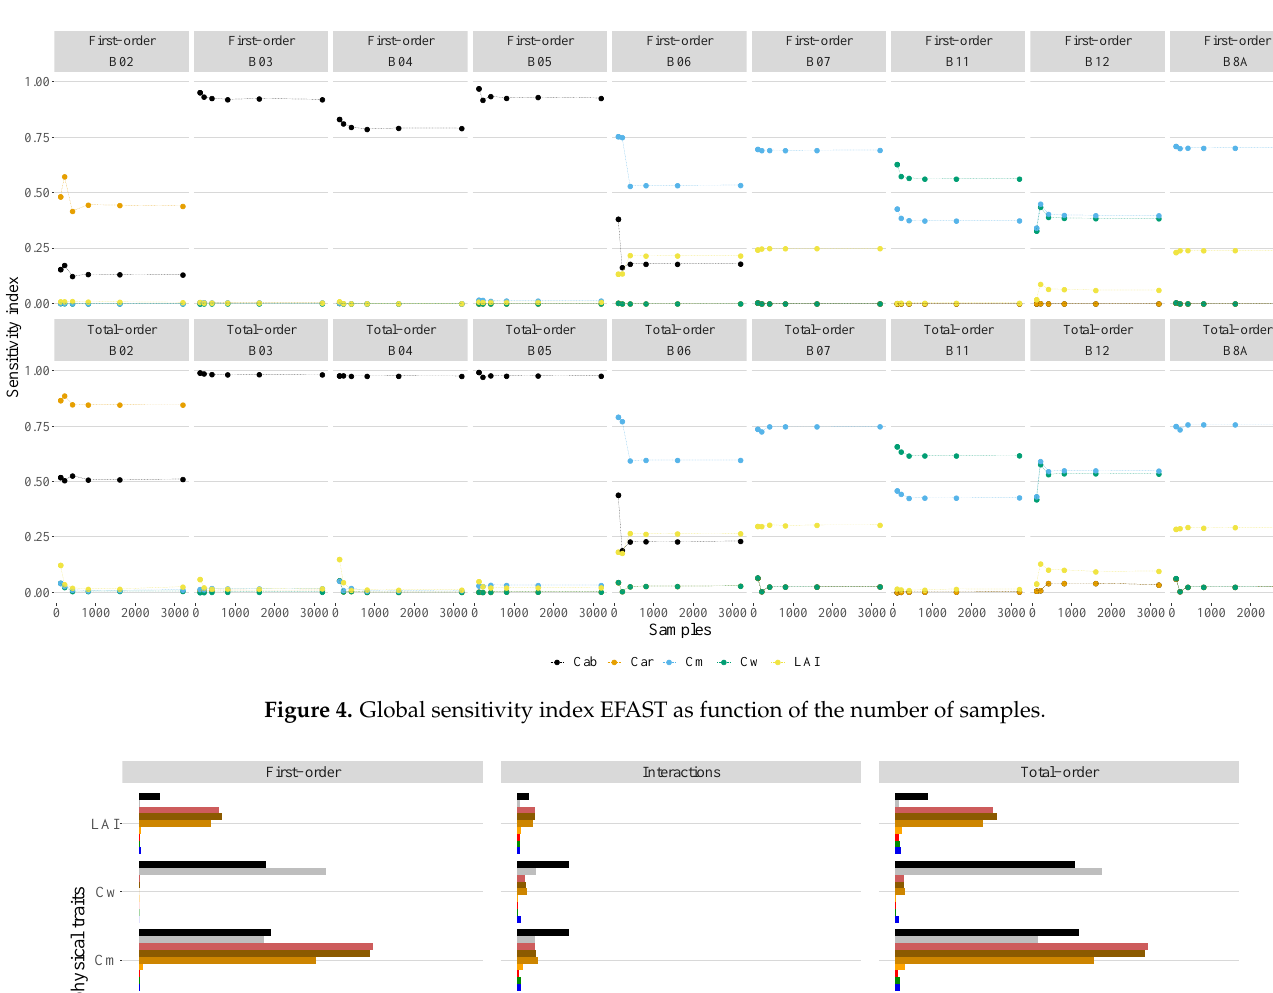
the red-edge region B6, B7 and B8A, and most of the sensitivity on each band was of first-order. C w was strongly dependent on bands B11 and B12, with some interaction effects occurring on B12. C m was shown to be sensitive to variations in multiple bands from the infrared region (B06, B07 and B8A) to the short-wave infrared region (B11 and B12). Some interaction between C m and C w can be observed in B12. Car was found to be exclusively dependent on the blue band (B2), which is of concern due to the high degree of interaction with C ab . This, combined with the lack of variation in reflectance (see Figure A2), indicates that Car cannot be detected by S2 data simulated by PROSAIL; therefore, we excluded it from the remainder of the analysis.